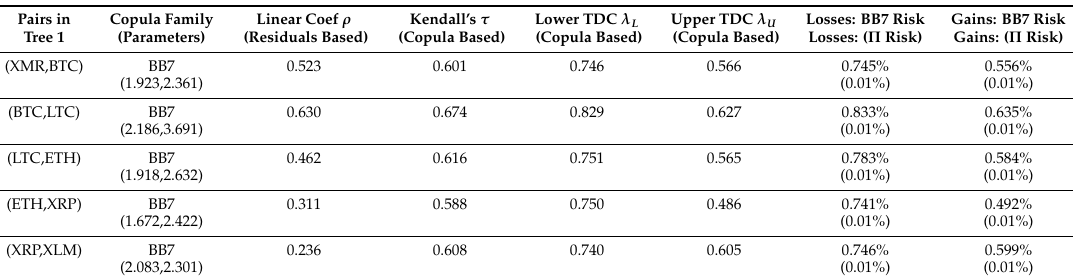
Table 4. Pair-copulas’ robust fits: copula family and estimates, dependence measures, the losses (gains) BB7-copula-based joint probability associated 1%-VaR in the upper row, and the π -copula-based risk under independence (bottom